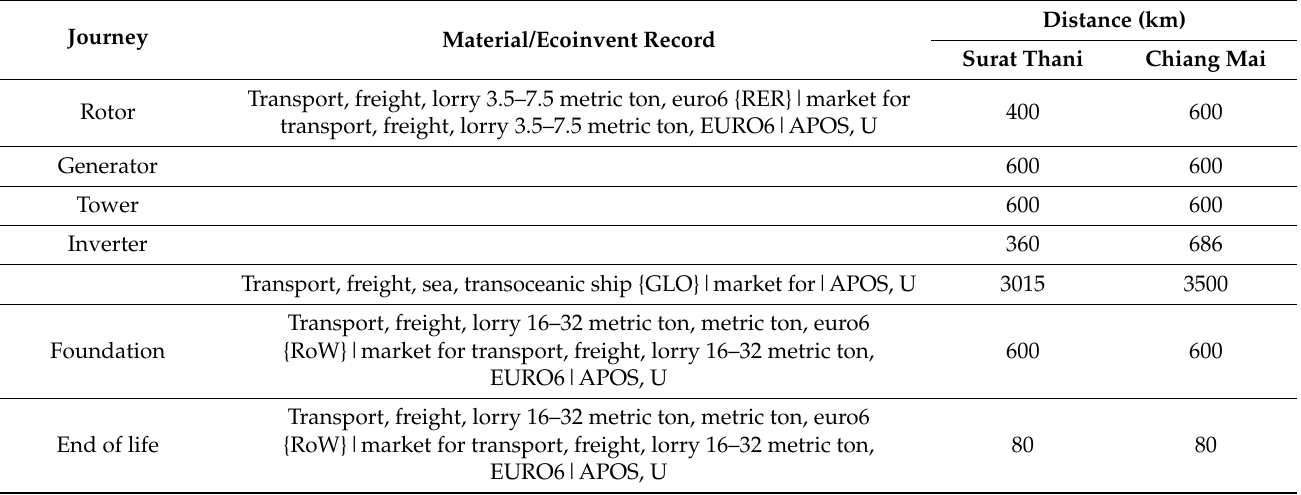
Table A7. Transport methods and distances for components, with Ecoinvent